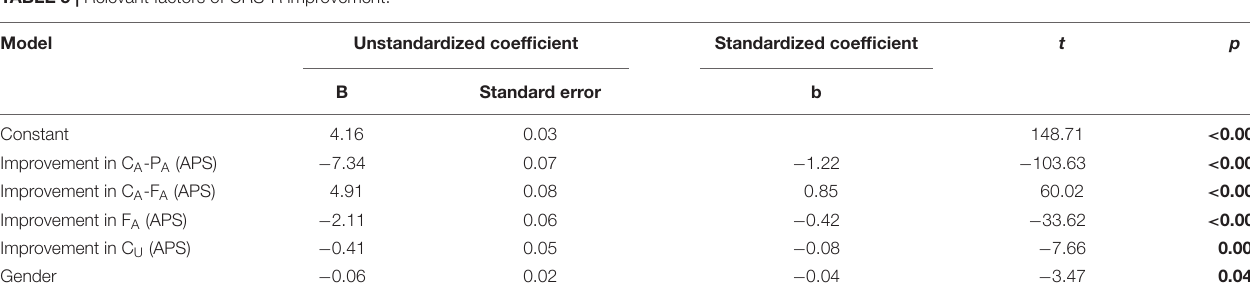
TABLE 5 | Relevant factors of CRS-R